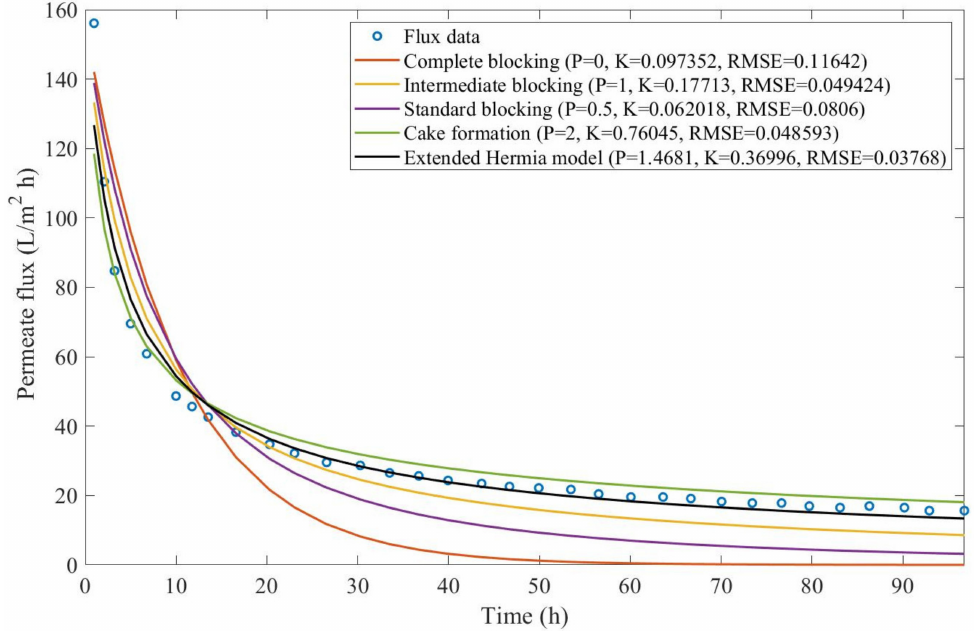
Figure A17. Model fitting for oily effluent ultrafiltration with CFR of 14 L/min and 104 kPa consider- ing the four original pore-blocking mechanisms and the extended Hermia model